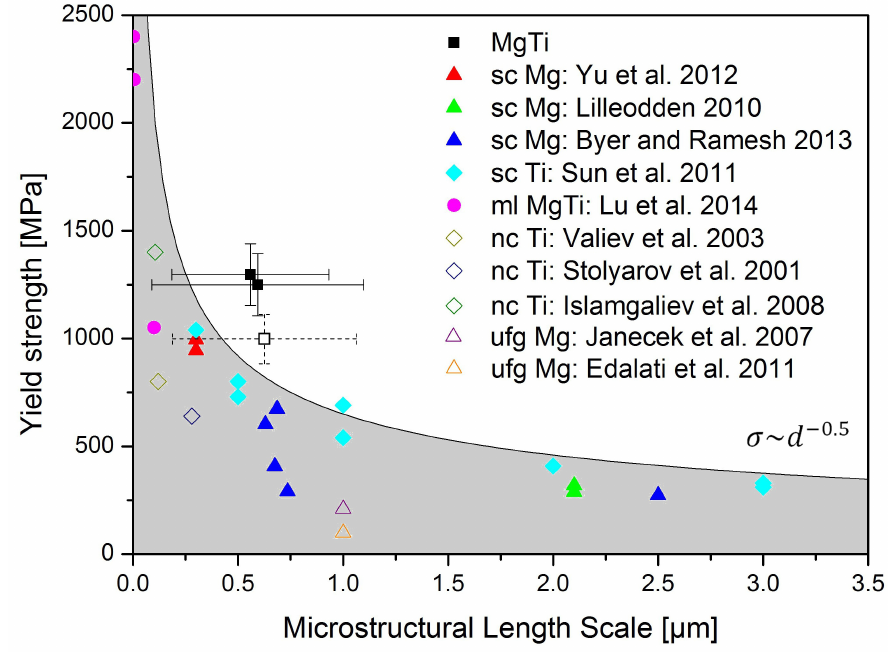
Figure 6. Yield strength comparison with literature data [10,26,34–41]. The microstructural length scale is either the pillar diameter (single-crystalline samples), the grain size (poly-crystalline samples) or the layer thickness (multilayer sample). The open black data point describes the sample containing internal defects. The grey region is bordered by a classical Hall-Petch equation [13,14] with a constant of −